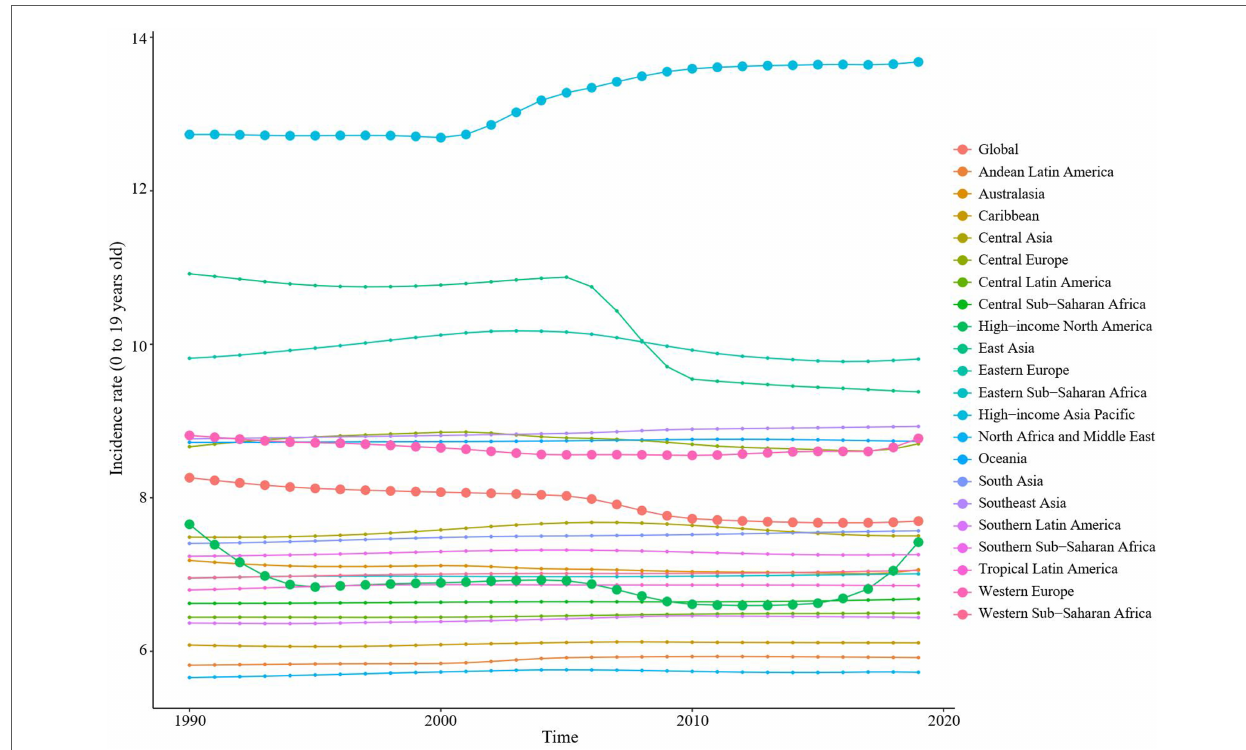
FIGURE 1 Trends in incidence of childhood myocarditis and cardiomyopathy from 1990 to 2019 in 21 regions worldwide. From 1990 to 2019, the incidence of childhood myocarditis and cardiomyopathy declined globally. The incidence of childhood myocarditis and cardiomyopathy did not change signi fi cantly in most regions, but increased in high-income Asia Paci fi c, high-income North America and Western